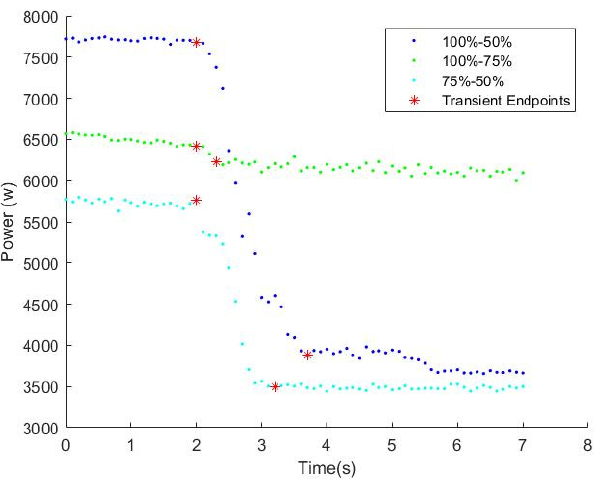
Figure 12. Results from the negative throttle step changes during ATC experimentation.